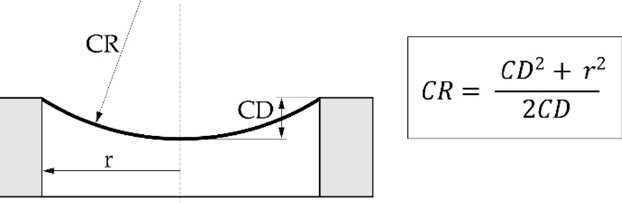
Figure 5. Relationship between the curvature depth (CD) and the curvature radius (CR) of a clamped circular diaphragm with a radius r.